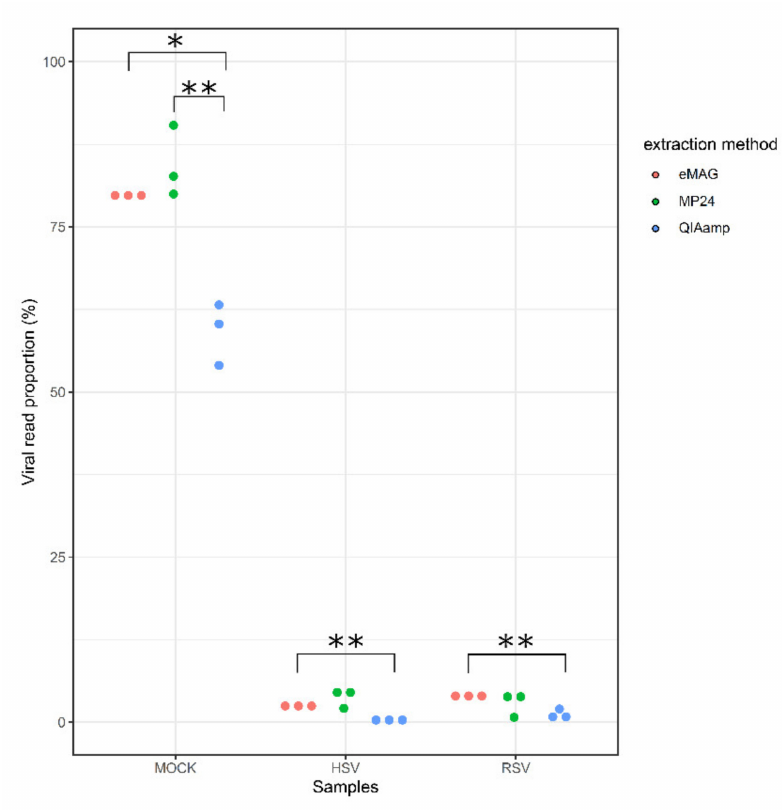
Figure 3. Distribution of the viral read proportion (%) according to the three extraction methods. QIAamp Viral RNA Mini Kit (QIAamp, blue dots), MagNA Pure 24 (MP24, green dots), and eMAG (eMAG, red dots) extraction methods for mock and clinical samples (HSV and RSV). HSV: herpes simplex virus; RSV: respiratory syncytial virus. The average of viral read proportions was